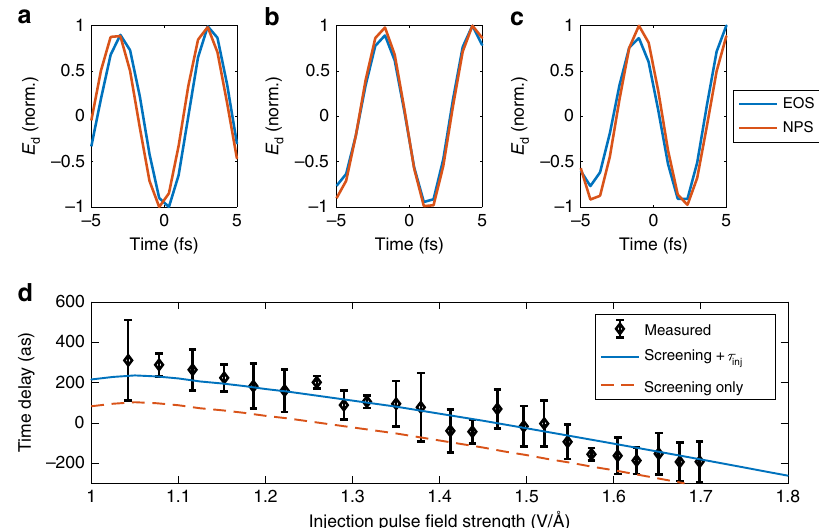
Fig. 4 Attosecond timing of light-induced transitions in a solid via simultaneous EOS and NPS. The two measured waveforms of the driving waveform E d exhibit a temporal shift due to the combination of delayed injection of charge carriers into the dielectric relative to the fi eld maximum of the laser pulse and the in fl uence of fi eld screening by free carriers, shown as the relative shift of the waveforms at injection pulse fi eld strengths of a 1.04 V Å − 1 , b 1.4 V Å − 1 , and c 1.7 V Å − 1 . The time shift ( d ) depends on the fi eld strength, decreasing as the amplitude of the injection fi eld increases. The measured values are compared to expectations of electric fi eld screening by the laser-induced free carriers, with and without a temporal delay fi tted to the experimental data, τ = 134 ± 93 as, comparable to the value of 75 as observed in the TDDFT calculations. Error bars represent the standard deviation of multiple inj measurements of the relative timing of the